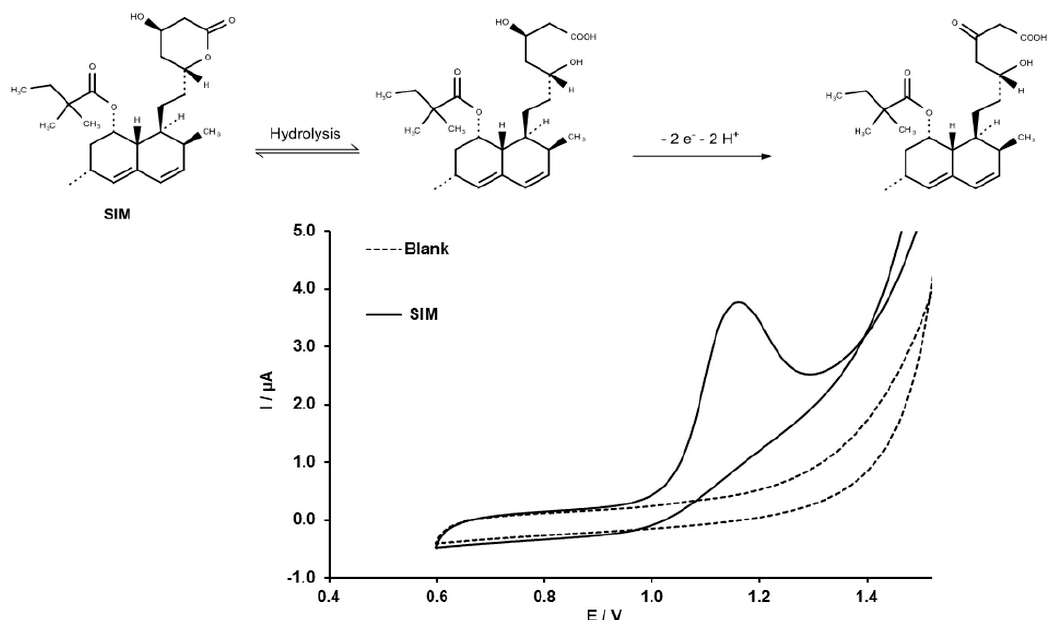
Figure 4. The CV of MWCNT-CPEs in 0.1 M H 2 SO 4 at and the CV of 5 × 10 − 4 M simvastatin (SIM) in 0.1 M H 2 SO 4 with MWCNTs, at a potential scan rate of 50 mV · s − 1 . The inset shows the electrochemical oxidation mechanism of SIM.